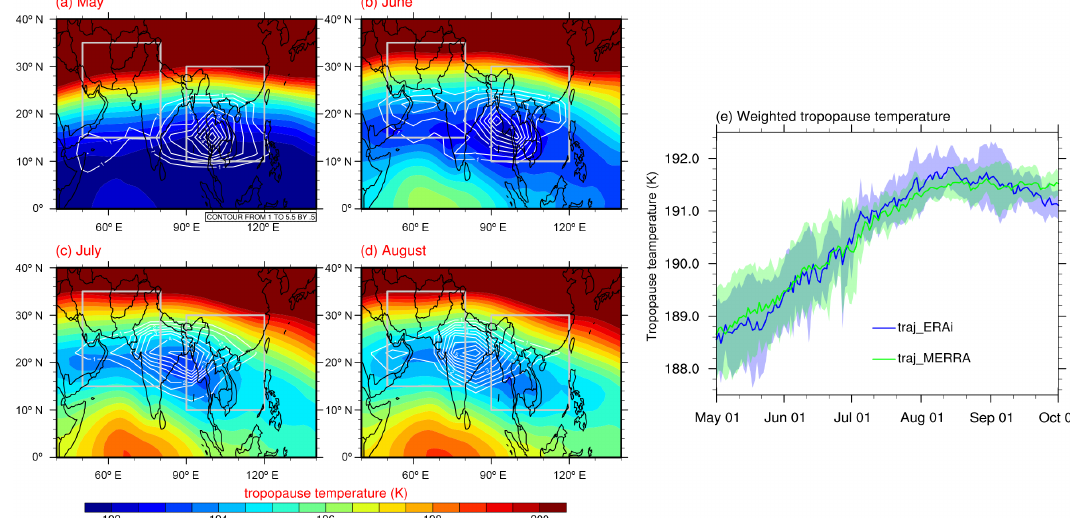
Figure 2. (a–d) Probability density distributions of last dehydration locations for air parcels located at 100hPa over the Asian monsoon region during May to August derived from traj_ERAi (white contours from 1 to 5.5% with an interval of 0.5%). Color shadings are averaged tropopause temperatures in ERA-Interim. The two boxes are the two domains distinguishing the west and east side of the Asian monsoon region in Fig. 3. (e) The average tropopause temperatures weighted by the dehydration frequency distributions in traj_ERAi (blue) and traj_MERRA (green) respectively. The color shadings indicate the corresponding standard deviation